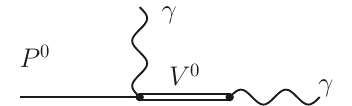
Figure 2 . Contribution to the P 0 ! (cid:13)(cid:13) decay with one resonance